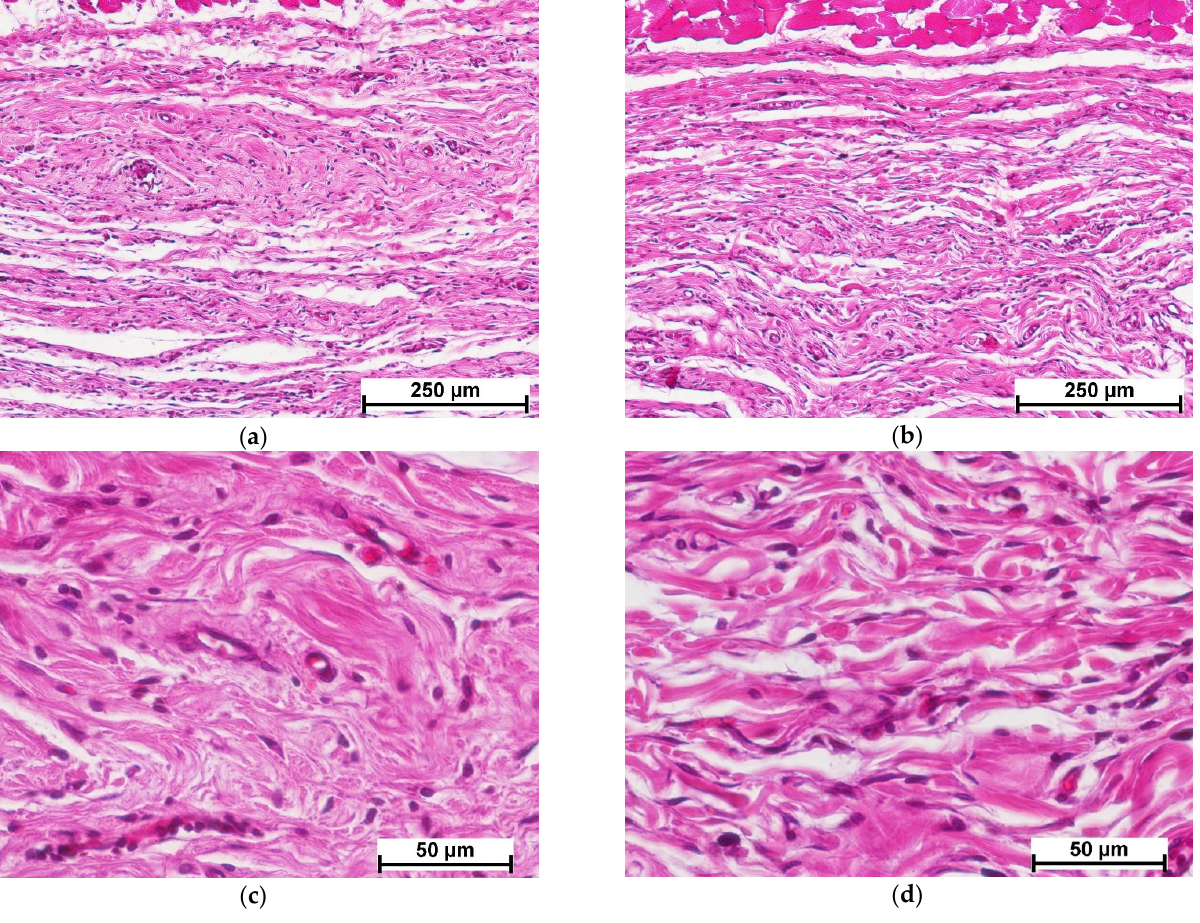
Figure 10. Histological picture—day 21. Comparison of cell-containing scaffold ( a , c ) and cell- containing collagen matrix ( b , d ). ( a , b )—implant site, general view, ( c , d )—connective tissue structure at the implant sites. Staining with hematoxylin–eosin.